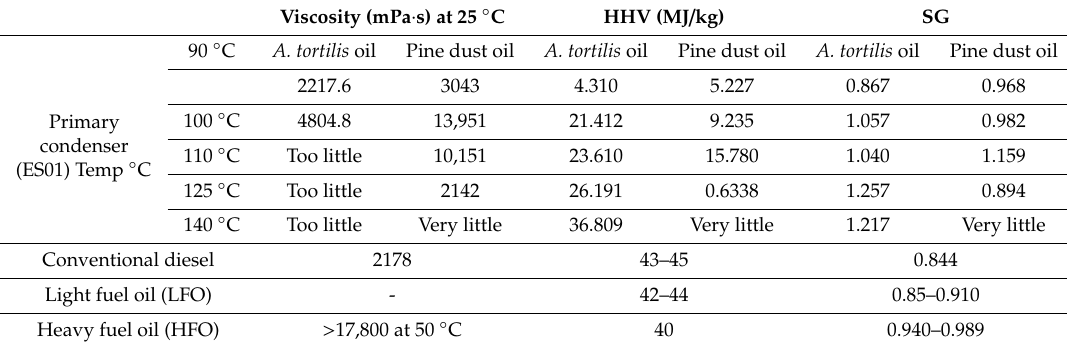
Table 4. Various bio-oil physicochemical properties compared to conventional